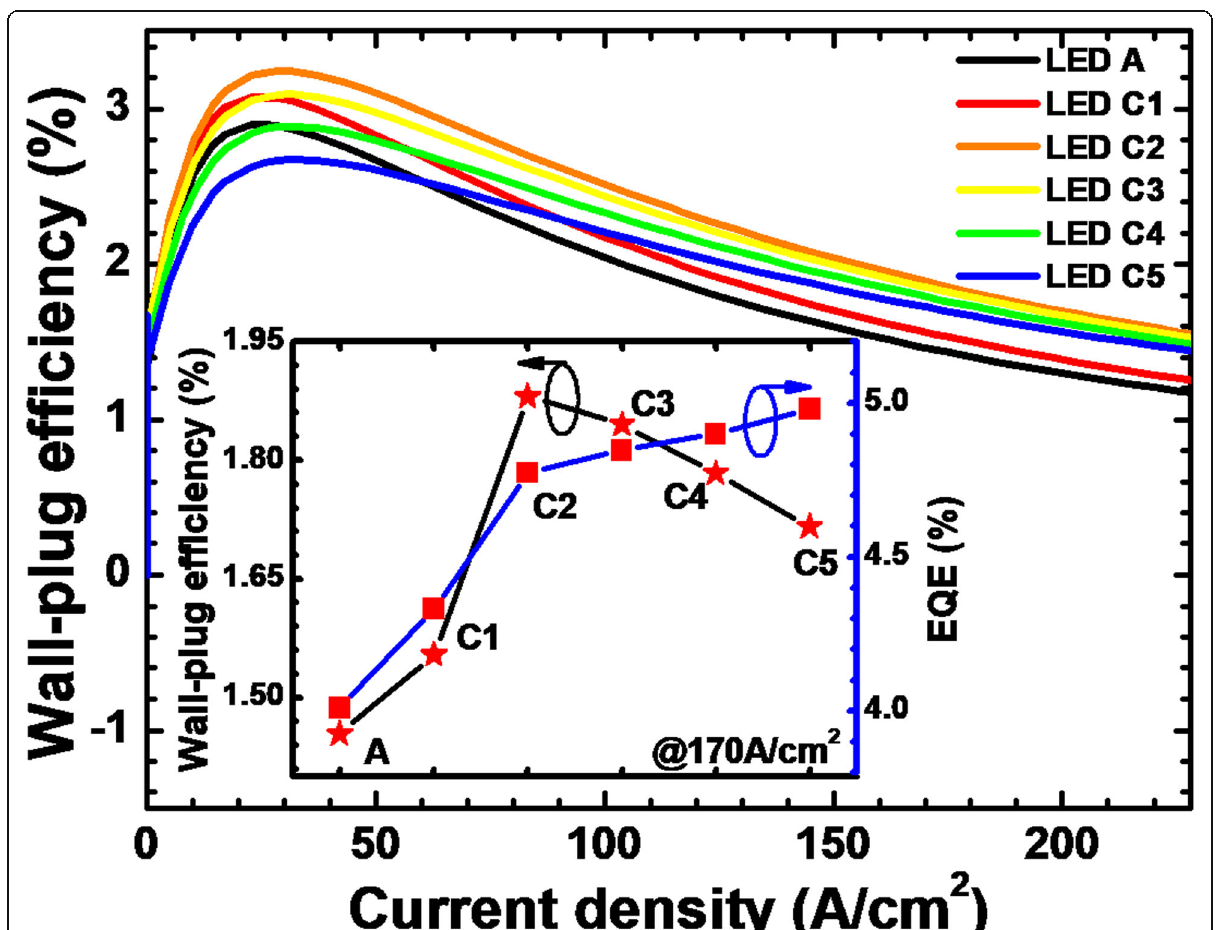
Fig. 8 Relationship between WPE and the injection current for LEDs A and C i ( i = 1, 2, 3, 4, and 5). Inset: the EQE and WPE for the investigated LEDs structured with a p-AlGaN layer with various AlN components when the current density is 170 A/cm 2